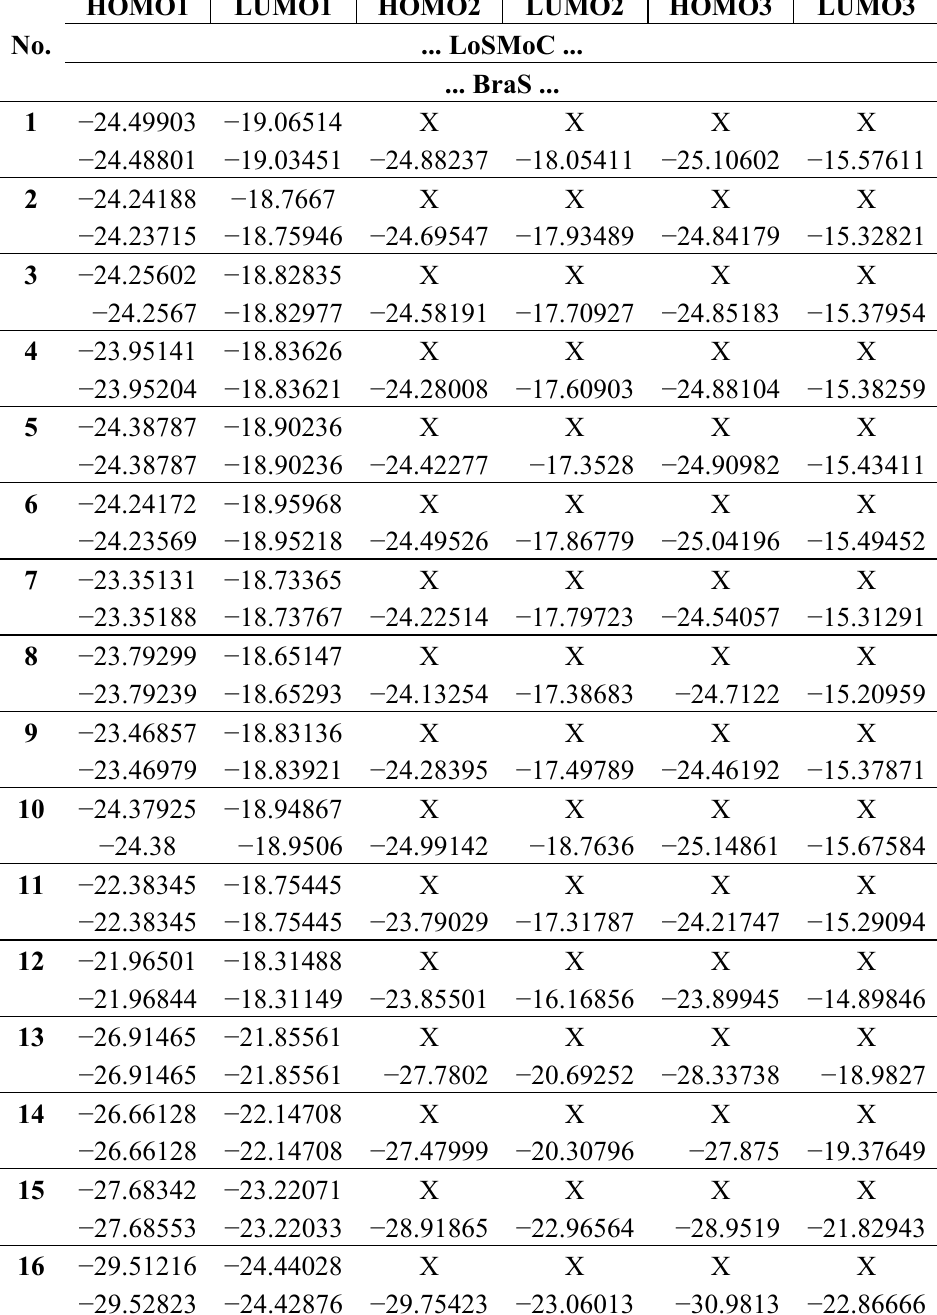
Table 2. The AM1 computed values (in electron-volts, eV) for the first three highest occupied and lowest unoccupied molecular orbitals in both variants as the longest SMILES molecular chain (LoSMoC, upper entry) and the Branching SMILES (BraS, lower entry), employed for computation of electronegativity ( χ ), chemical hardness ( η ), chemical power ( π ) and electrophilicity ( ω ), for the compounds of Table 1. Note that, in either LoSMoC or BraS forms, the overall compound was considered as carrying the [+2n] charge due to removed electronic pair out of each “broken bond” in SMILES configurations for compounds of Table 1. “X” indicates the truncation to the first order of HOMO and LUMO in LoSMoC calculations of electronegativity and chemical hardness of equations (14) and (15),